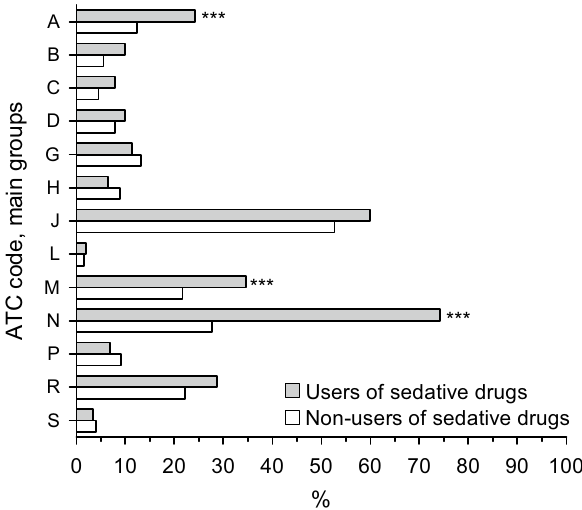
Figure 2. Proportion of primiparous women divided into sedative drug users and non-users who purchased some other prescription drugs than sedative drugs within 90 days before conception, during pregnancy or within 90 days after delivery. Prescription drug purchase with ATC codes N03AE (clonazepam), N05BA (benzodiazepine derivatives anxiolytics), N05CD (benzodiazepine derivates), or N05CF (benzodiazepine related drugs) were considered as sedative drugs. Hommel’s adjustment was applied to correct levels of significance for multiple testing: *p < 0.05, **p < 0.01, ***p < 0.001. ATC anatomical therapeutic chemical classification system codes, A alimentary tract and metabolism, B blood and blood forming organs, C cardiovascular system, D dermatological drugs, G Genitourinary system and reproductive hormones, H systemic hormonal preparations, excluding reproductive hormones and insulins, J anti-infectives for systemic use, L antineoplastic and immunomodulating agents, M musculoskeletal system, N nervous system excluding sedative drugs, P antiparasitic products, insecticides and repellents, R respiratory system, S sensory